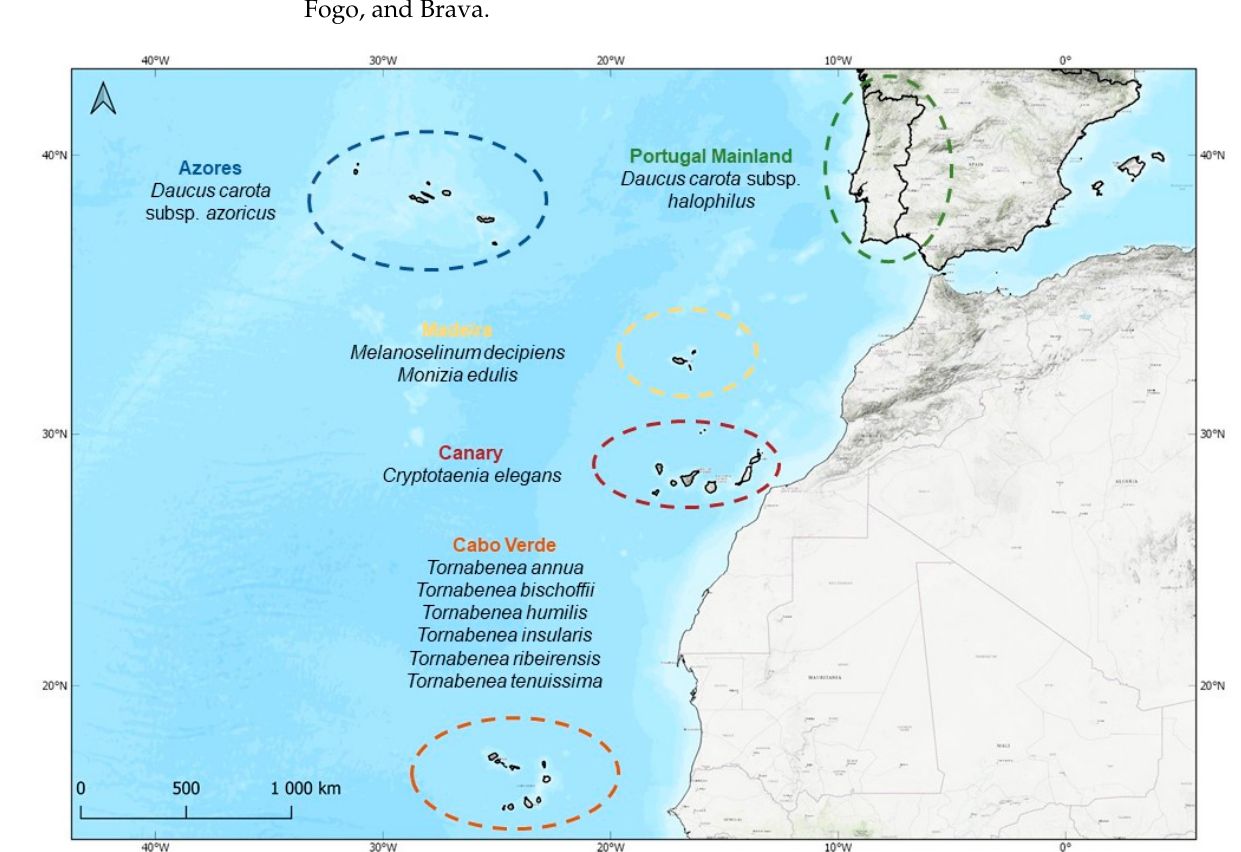
Figure 5. Distribution of the target endemic species in Macaronesia and mainland Portugal.